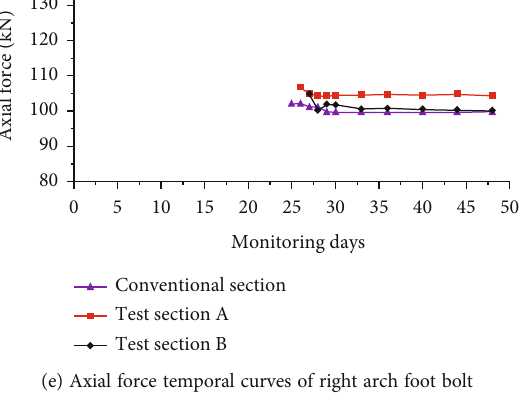
Figure 9: Axial force temporal curves of